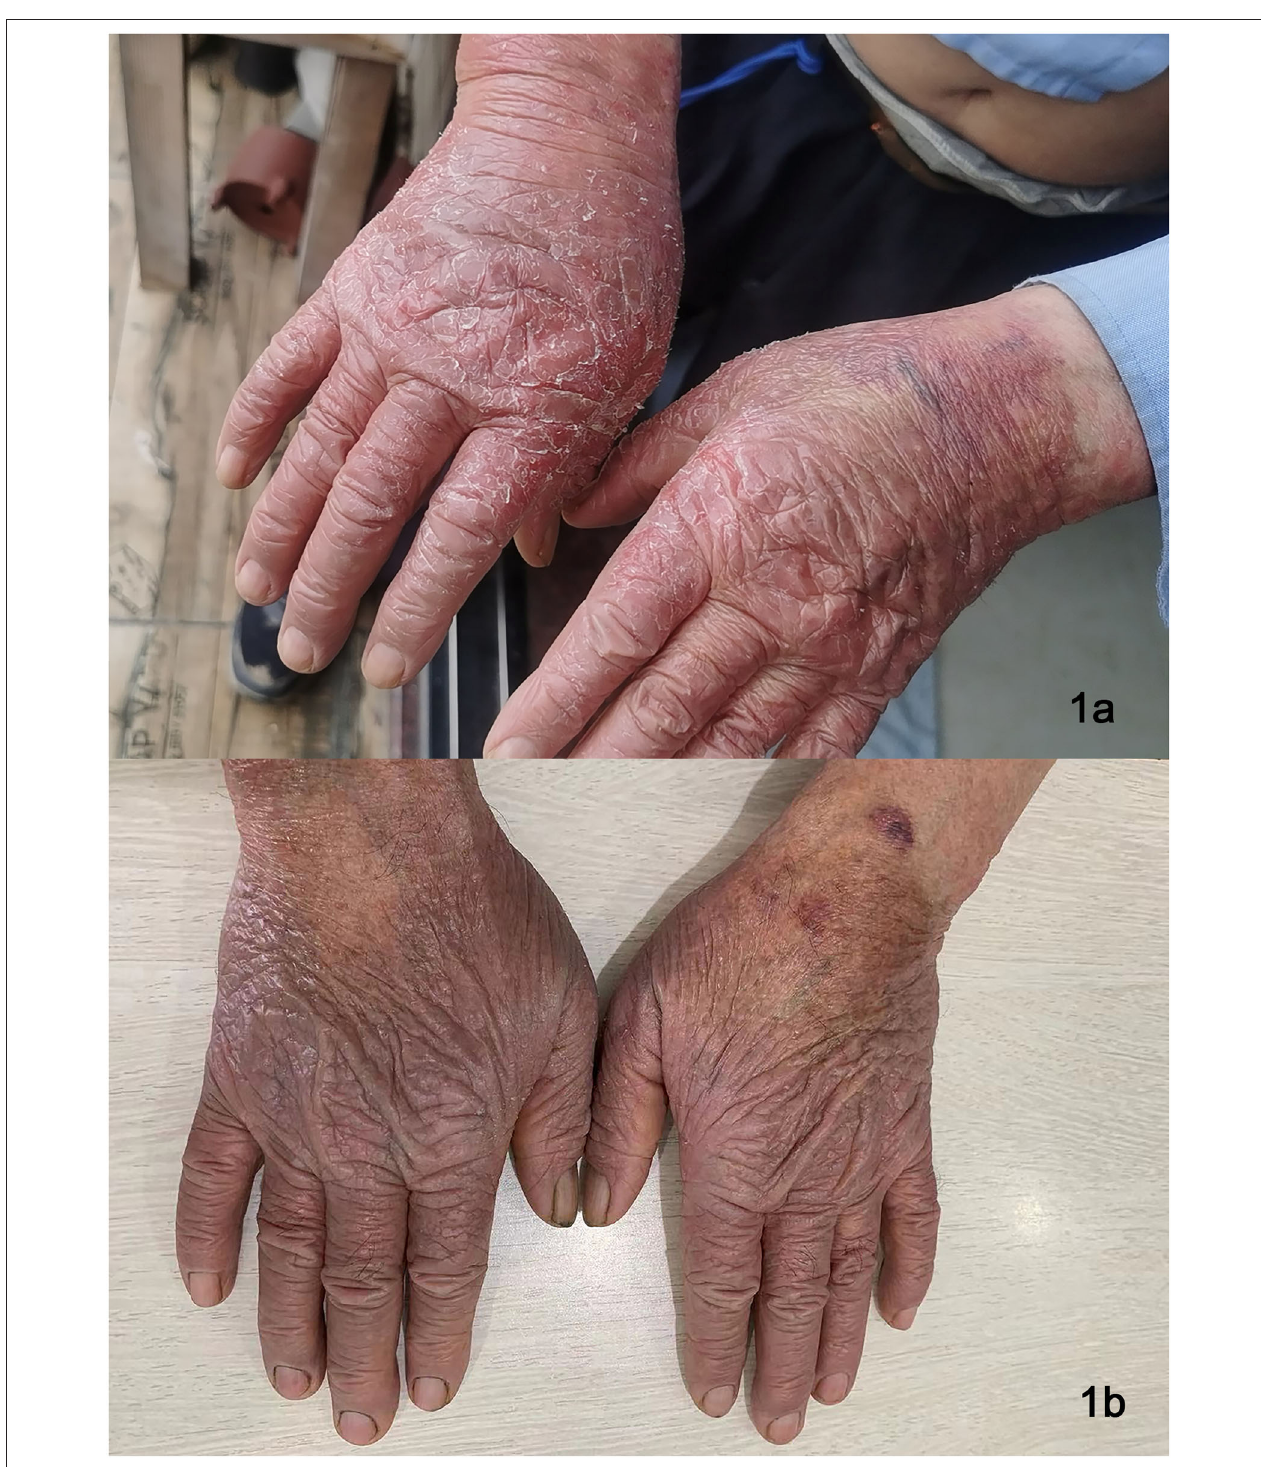
FIGURE 1 | Lesions on dorsa of hands of Patient 2 before dupilumab therapy (a) , remarkably improved lesions on dorsal hands after treatment (b) .